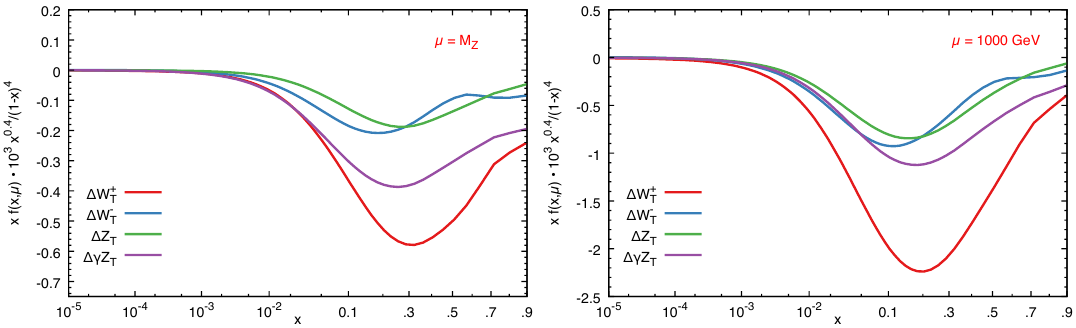
Figure 6 . The polarized gauge boson PDFs f (purple) for (cid:22) = M Z and (cid:22) = 1000 GeV.